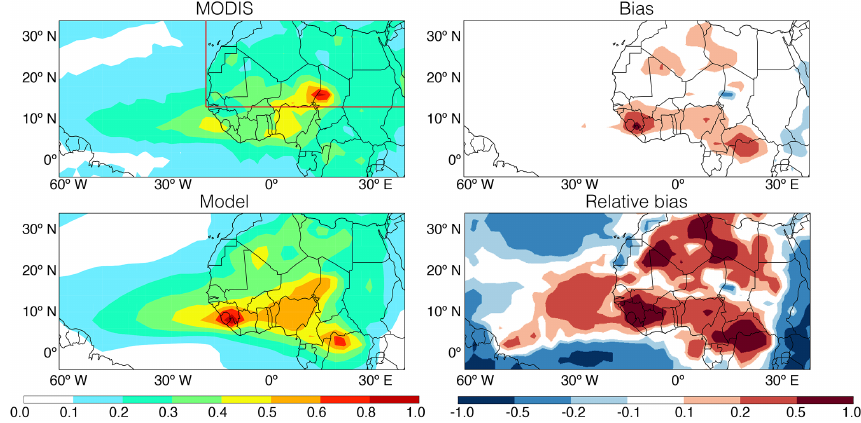
Figure 4. Spatial distributions of observed and simulated AOD at 550nm over the rectangle region between 60 ◦ W–40 ◦ E and 5 ◦ S–35 ◦ N averaged over January–April 2014. Observations are from MODIS level 3 daily data. The left panels are for MODIS and model AOD using the color bar on the left and the right panels are for the bias (model − MODIS) and relative bias (model/MODIS − 1) using the color bar on the right. The red box in the upper left panel indicates the dusty regions defined in the